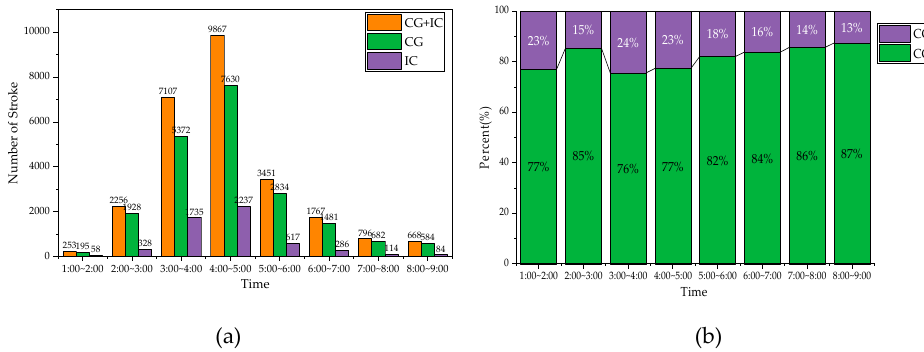
Figure 13. ( a ) The distribution of lightning detection results of Advanced Direction-Time Lightning Detection System (ADTD) in different hours. Orange indicates all types of lightning, green indicates cloud-to-ground (CG) stroke, and purple indicates intracloud (IC) stroke. ( b ) IC and CG strokes as a percentage of total stroke in different hours.